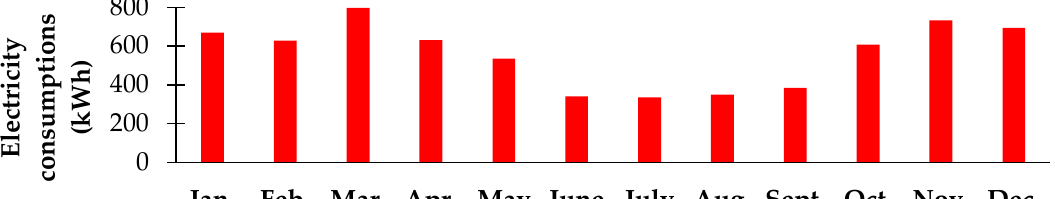
Figure 6. Monthly electricity consumption of the analyzed residential user.